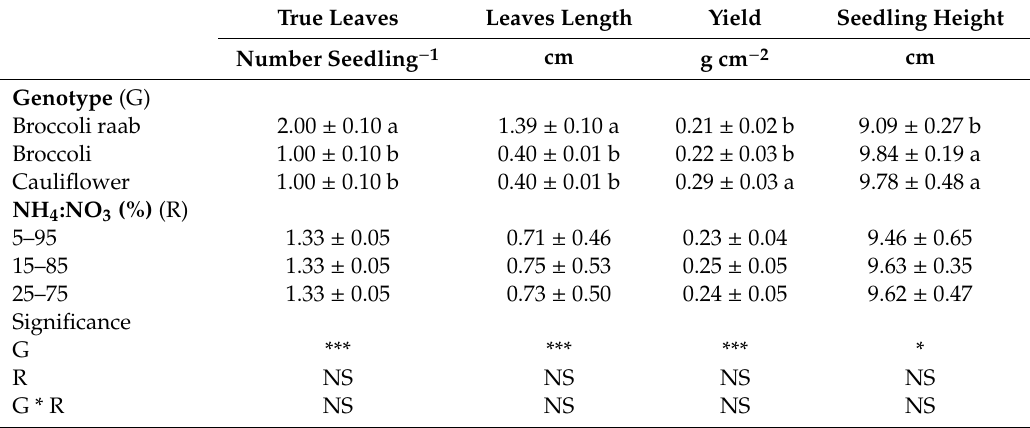
Table 5. Main e ff ects of genotypes and the NH 4 :NO 3 ratio on the number and length of true leaves, yield and height of microgreens (second